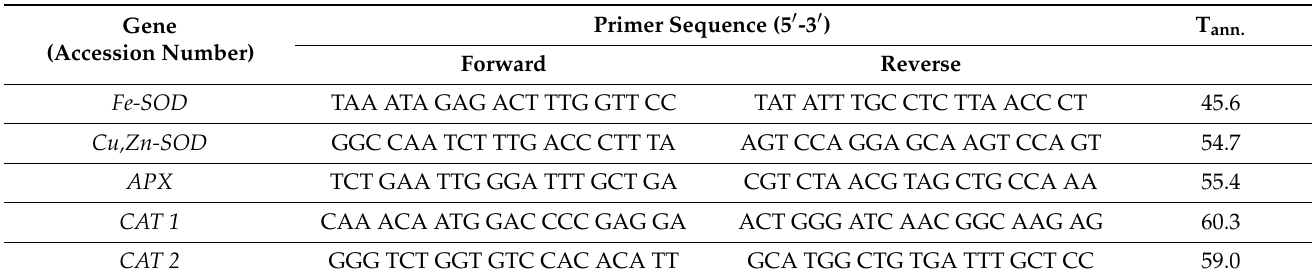
Table 1. Primer sequences (Forward and Reverse) and annealing temperature (T ann .) of target genes used for RT-qPCR